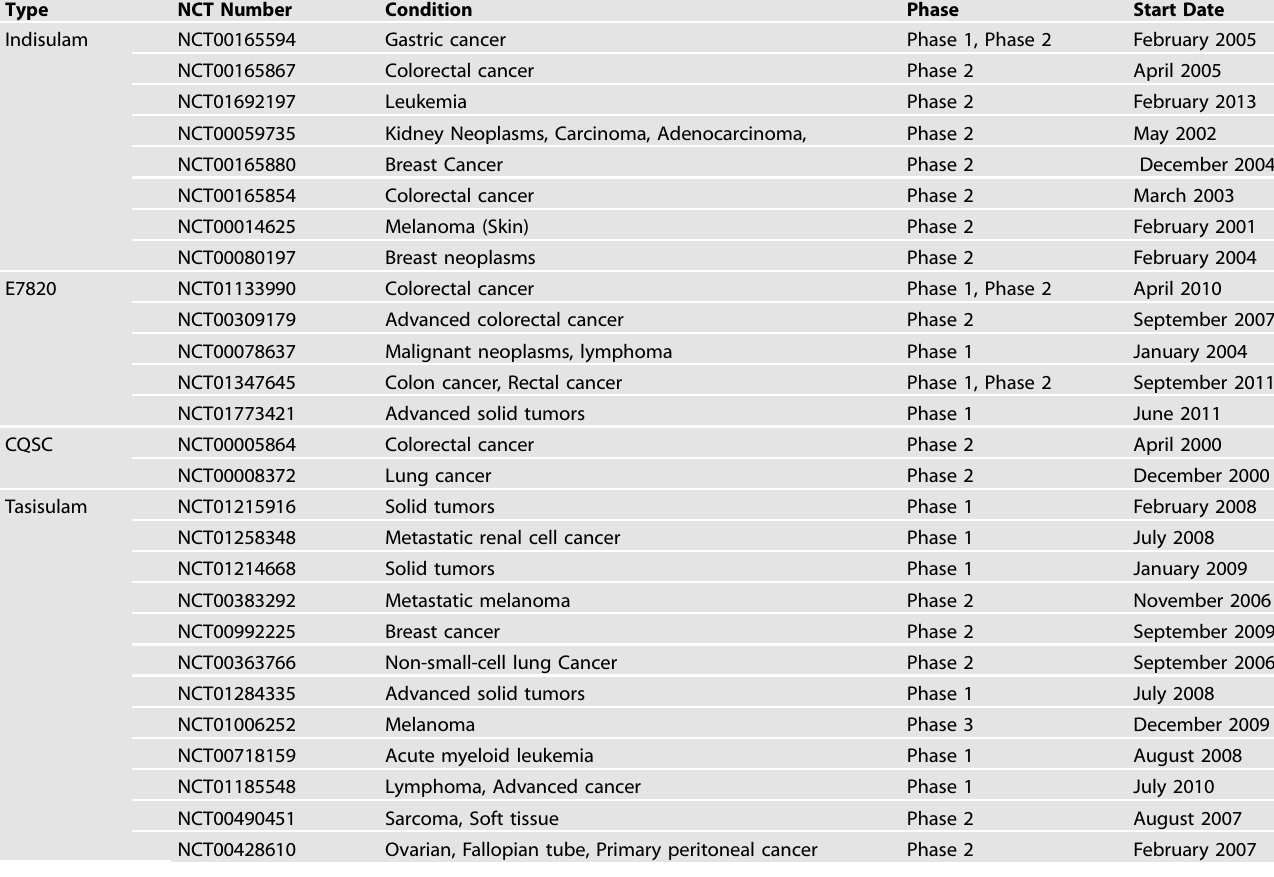
Table 2. Clinical trials of aryl sulfonamides.